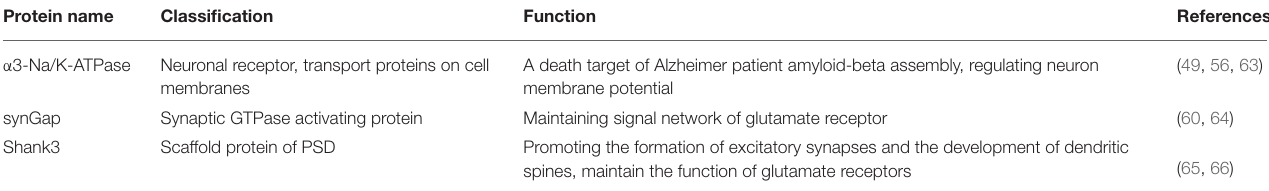
TABLE 3 | Function of synaptic protein targets of amyloid beta oligomers.